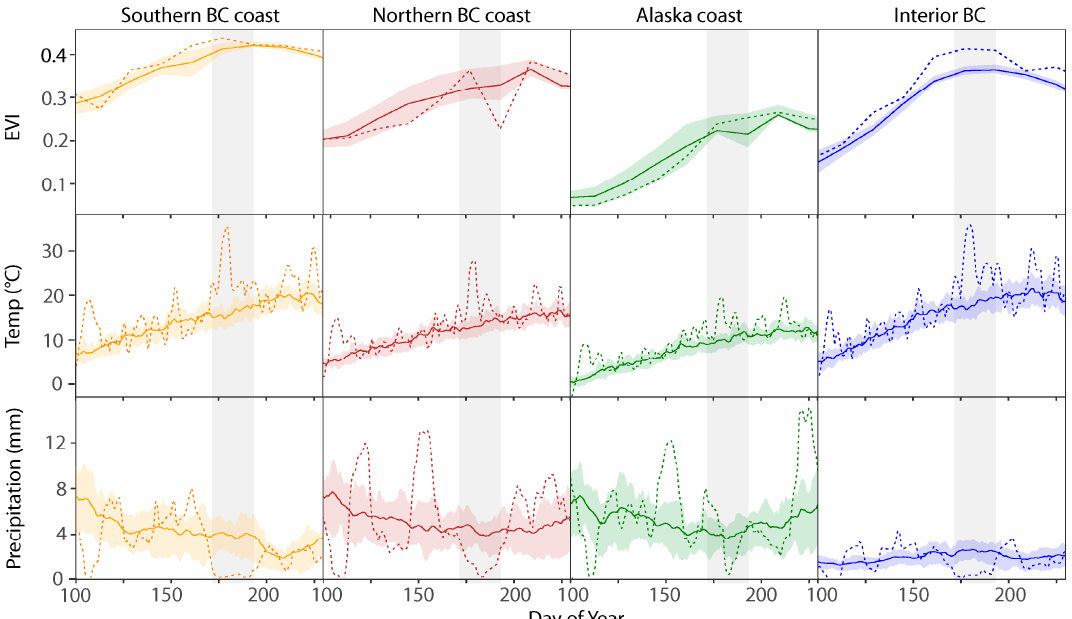
Figure 2. EVI anomalies for forested landcover in the 16-day time interval following the heat wave. Regions of similar vegetation response, subsequently used for numerical analysis, are highlighted with colored polygons, manually delineated based on regional response patterns for time series analysis of coastal and interior ecosystems (Figure 3).